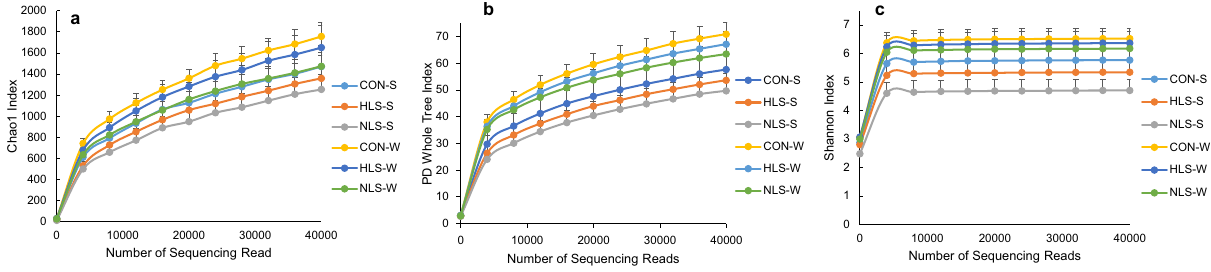
Figure 1. Diversity of intestinal microbiota of piglets at different stages. Alpha diversity indices including Chao1 ( a ), PD whole tree ( b ), and Shannon ( c ) were observed at each number of sequencing